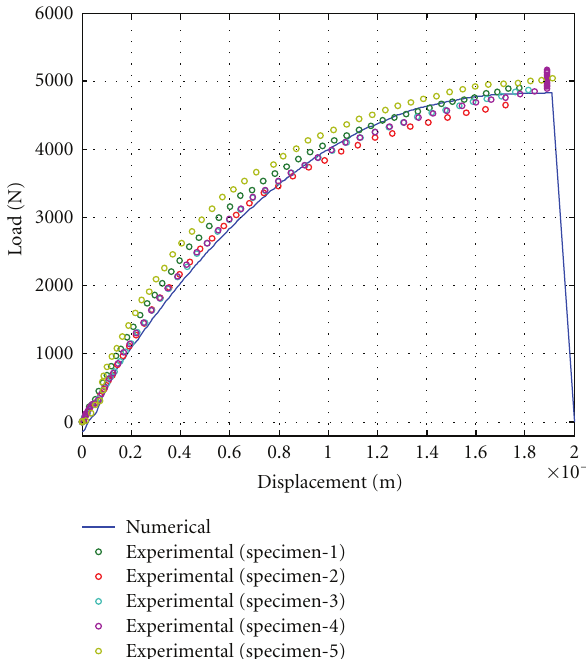
Figure 22: Comparison between numerical predictions and experimental results for the in-plane shear tests.